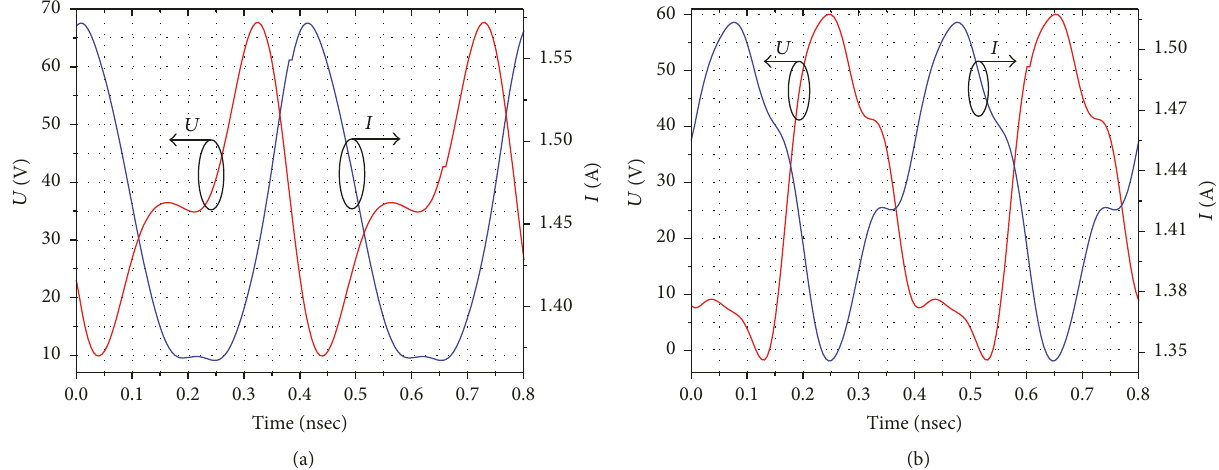
Figure 6: Simulated drain current and voltage time domain waveform for (a) conventional structure and (b) improved structure.